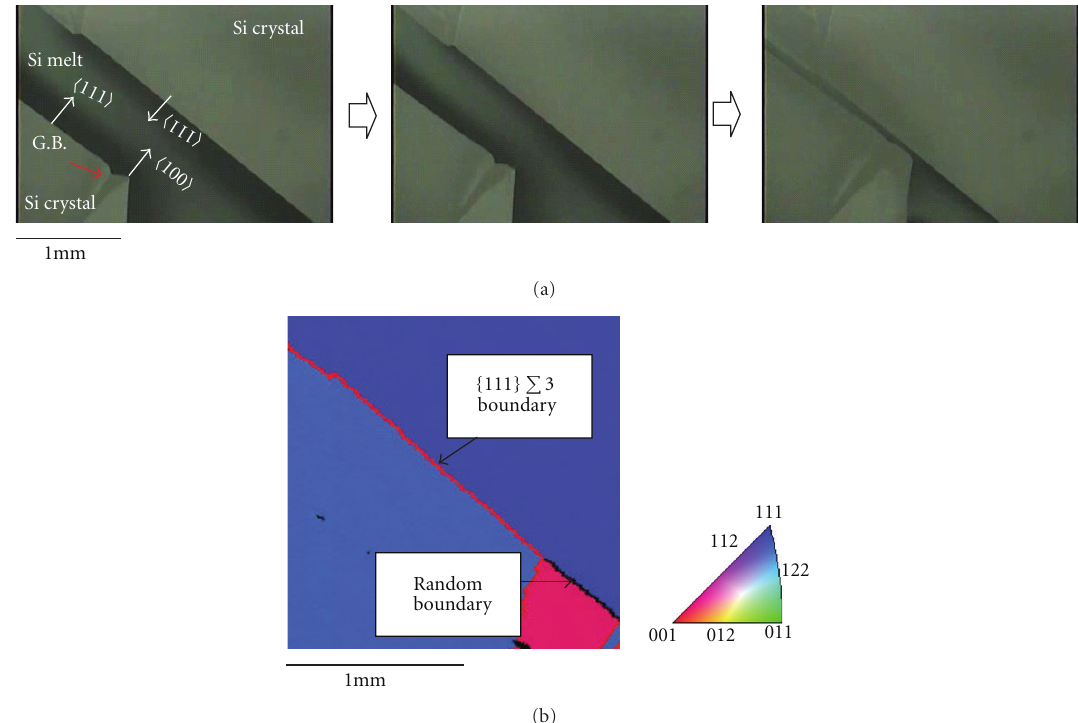
Figure 7: (a) Growth behavior of two Si crystals when they meet during crystallization. In the underlying crystal, the shapes of the growing interface are di ff erent on both sides of the grain boundary indicated by the arrow [41]. (b) Result of EBSP analysis of region observed in (a). The orientation vertical to the grain boundary is shown in color using the inverse pole figure triangle. The grain boundary is also shown in color in accordance with the grain boundary characteristics [41].